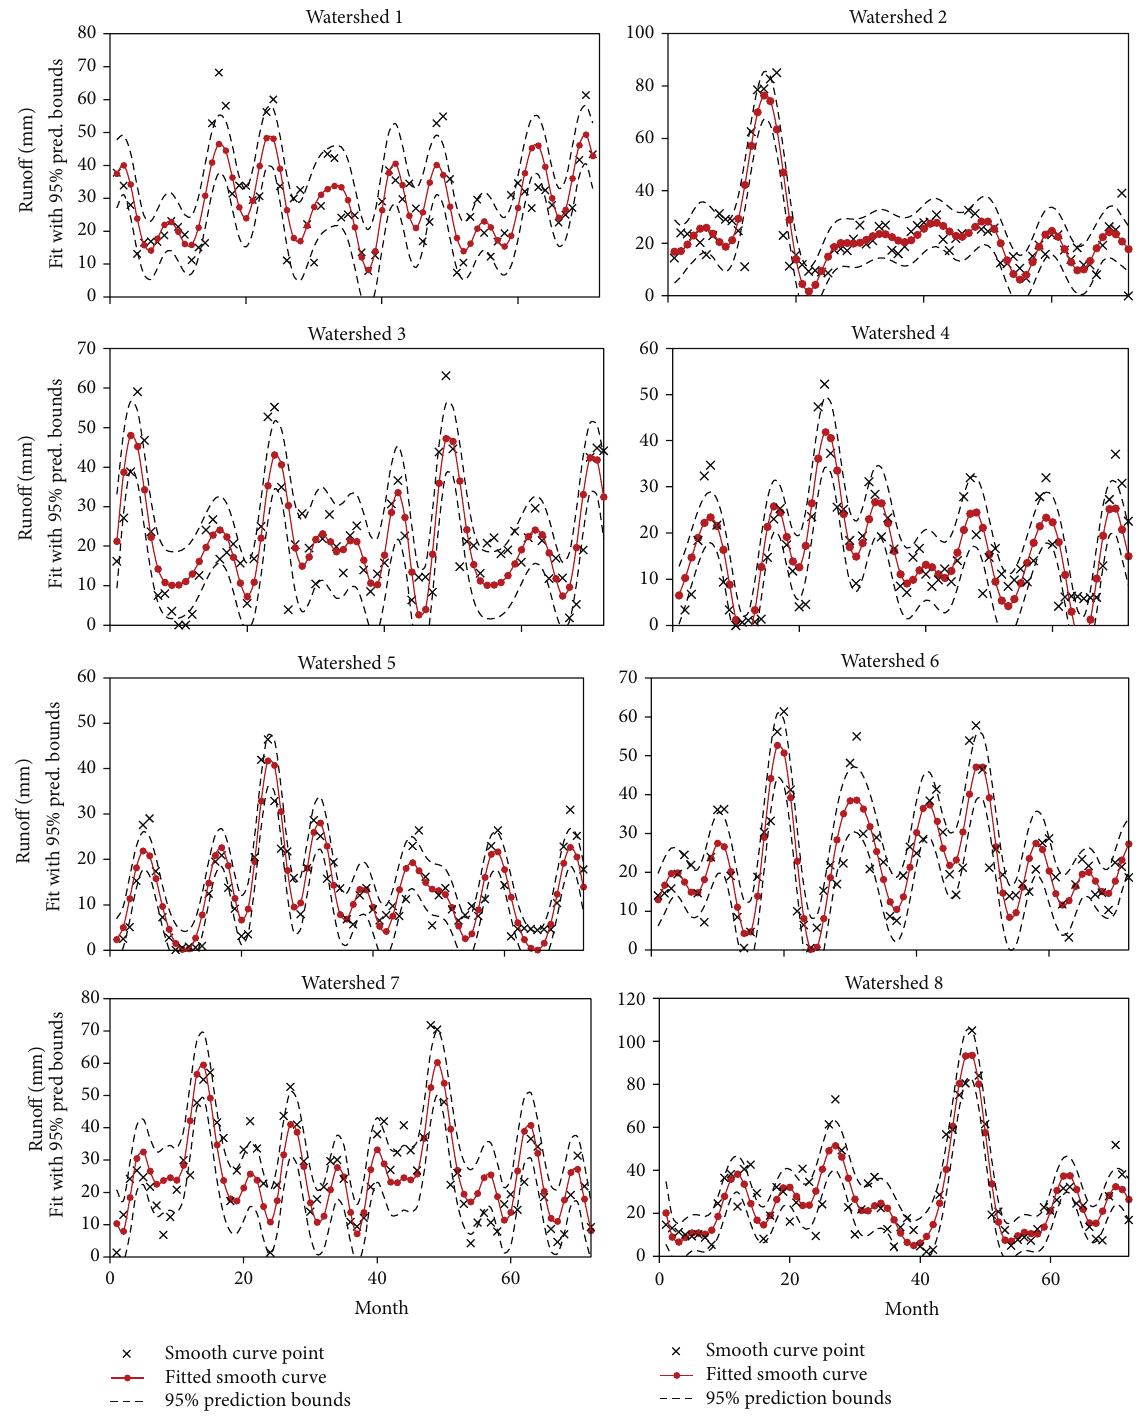
Figure 8: Smoothing and fitted curve with 95% prediction bound of eight